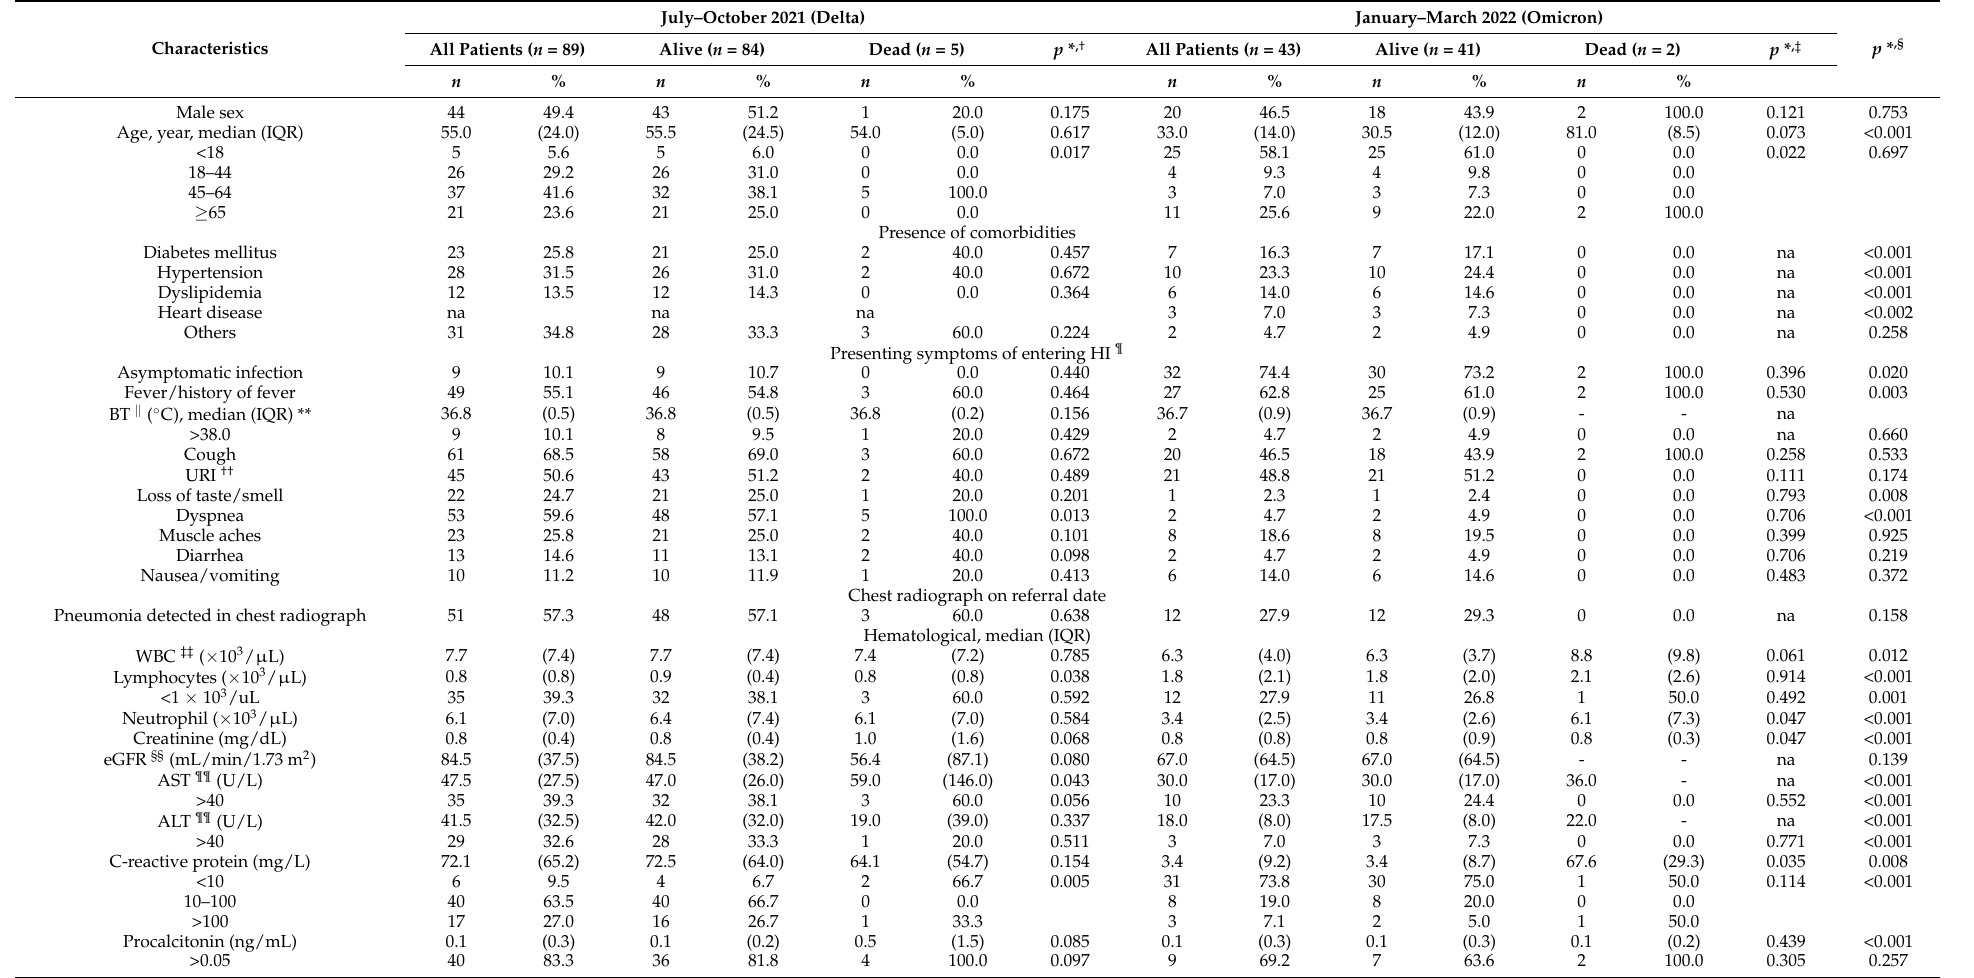
Table 2. Demographic, clinical, and laboratory findings of all of patients referred back for in-patient care and compared between those during the Delta and the Omicron pandemic